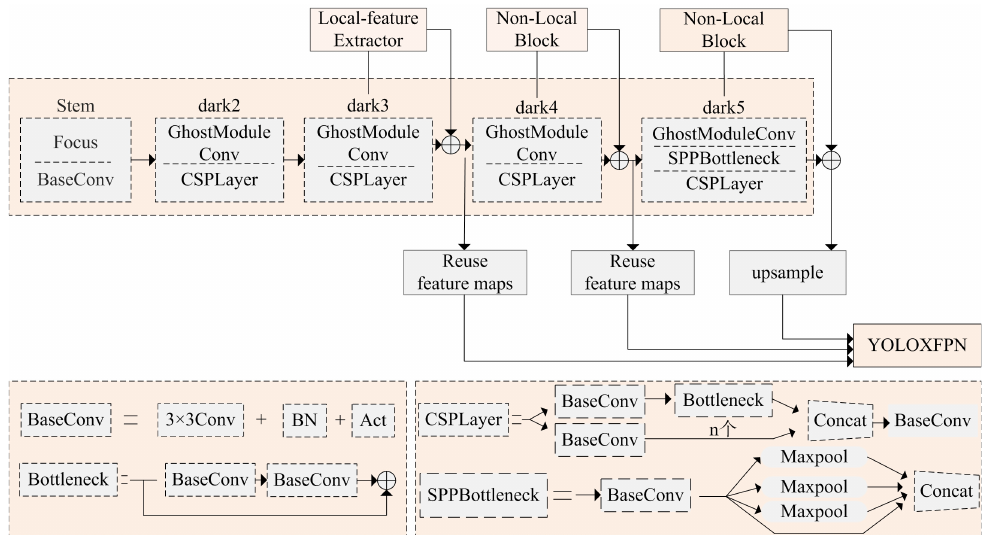
Figure 4. Internal structure of our proposed intelligent weighted object detector.